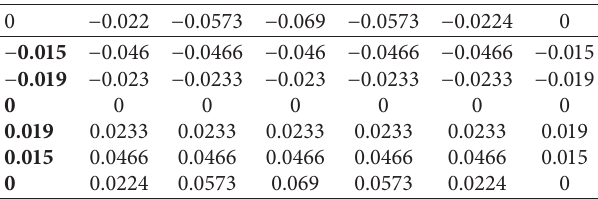
imaginary mask. 11